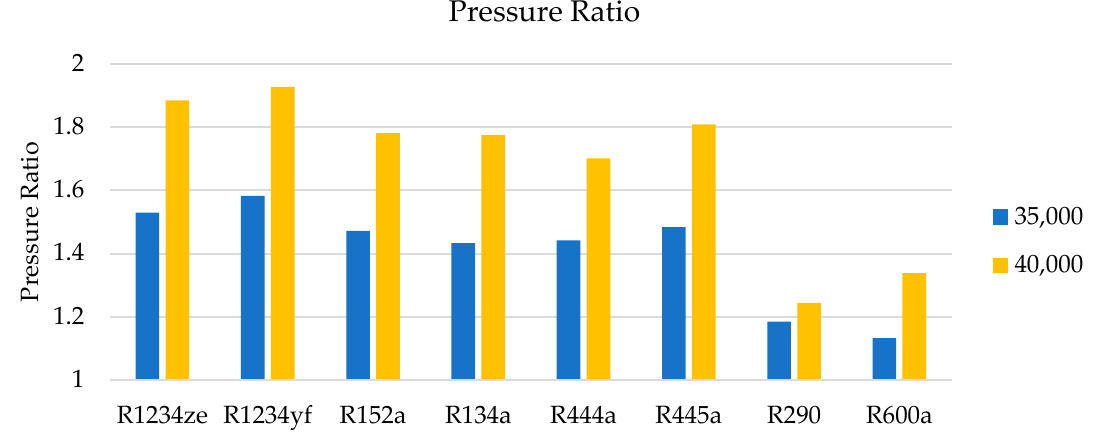
Figure 13. Comparison of Pressure Ratio Achieved for each Working Fluid at an RPM of 35,000 and 40,000.